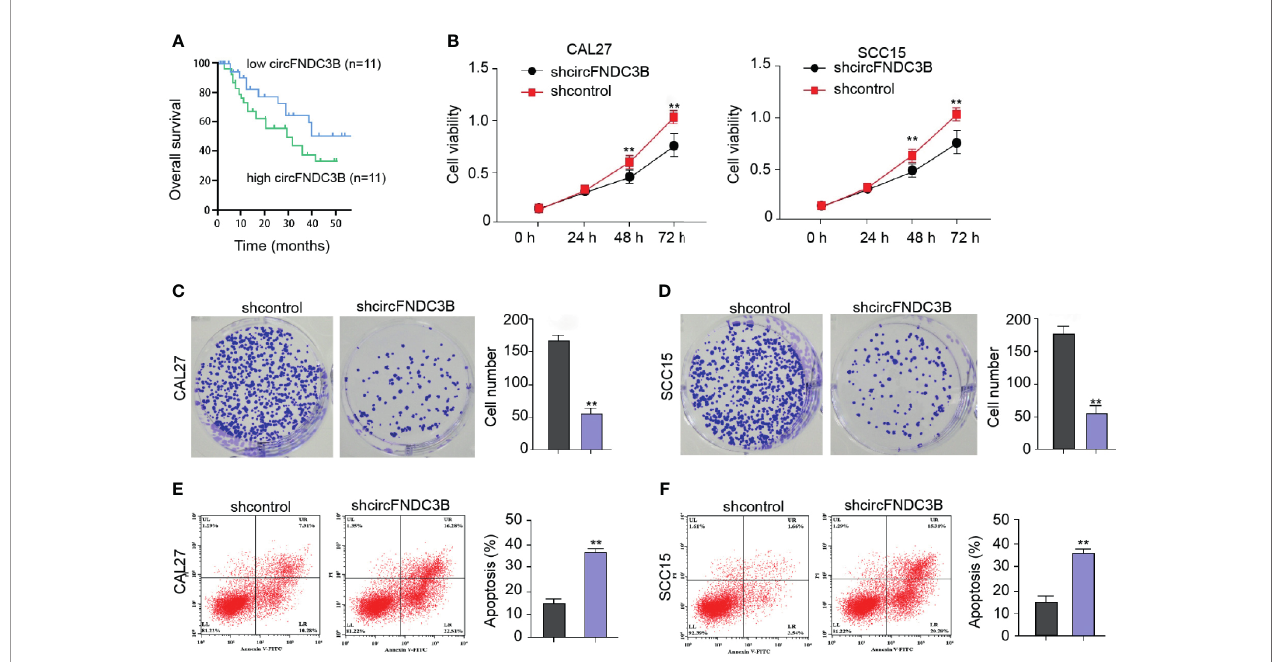
FIGURE 2 | CircFNDC3B contributes to OSCC cell proliferation in vitro . (A) The expression of circFNDC3B was analyzed by qPCR in the clinical OSCC tissues and the OSCC samples were divided into two group according to the circFNDC3B expression. The correlation of circFNDC3B with the prognosis of OSCC patients was evaluated by the overall survival analysis. (B – F) The circFNDC3B shRNA treated the CAL27 and SCC15 cells. (B) CCK-8 assays of cell viability. (C, D) Colony formation assays of cell proliferation. (E, F) Flow cytometry analysis of cell apoptosis. N = 3, mean ± SEM: ** P < 0.01.